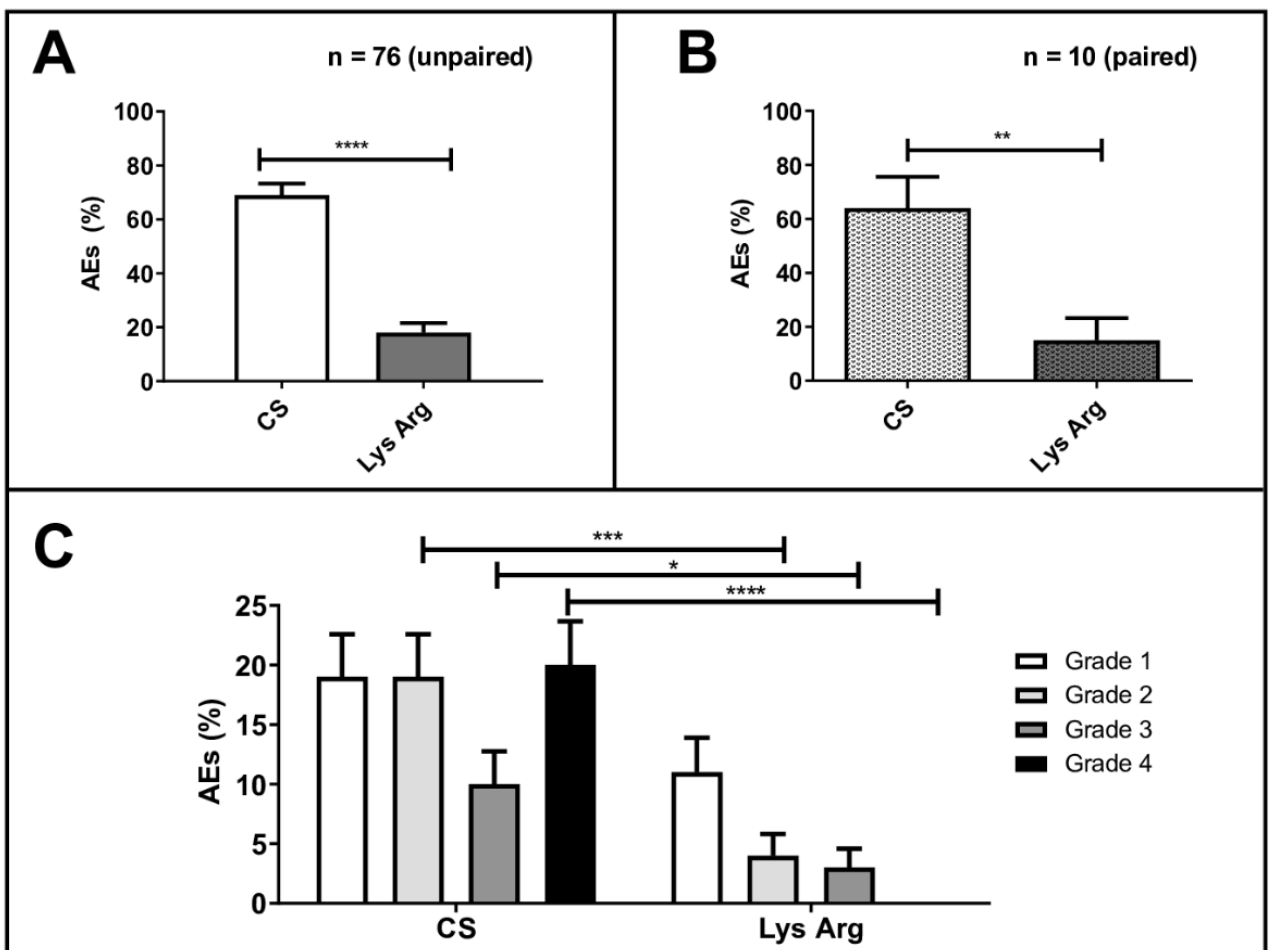
Figure 2. Percentage adverse events (AEs) in all patients ( n = 76) treated with the commercial solution (CS) or the lysine–arginine preparation (LysArg) ( A ), in 10 patients who received both solutions ( B ) and distribution according to WHO grade ( C ). Significant levels: * p < 0.05; ** p < 0.01; *** p < 0.001 and **** p < 0.0001. Bars plot SD values. Table 4. Individual adverse event occurring in patients per group.